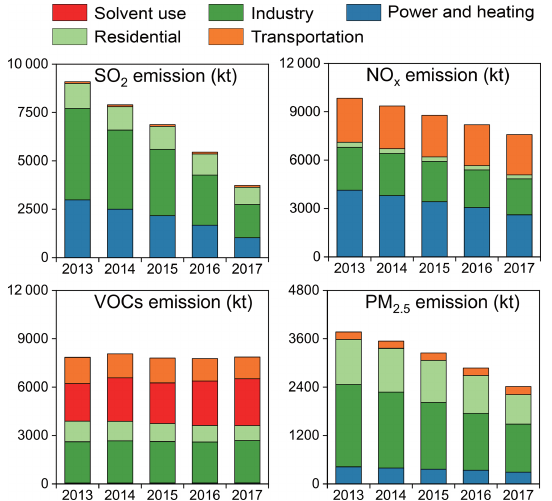
Figure 6. Changes in anthropogenic emissions of SO 2 , NO x , VOCs, and primary PM 2 . 5 in the areas surrounding Beijing during 2013–2017. The regions include Tianjin, Hebei, Henan, Shandong, Shanxi, and Inner